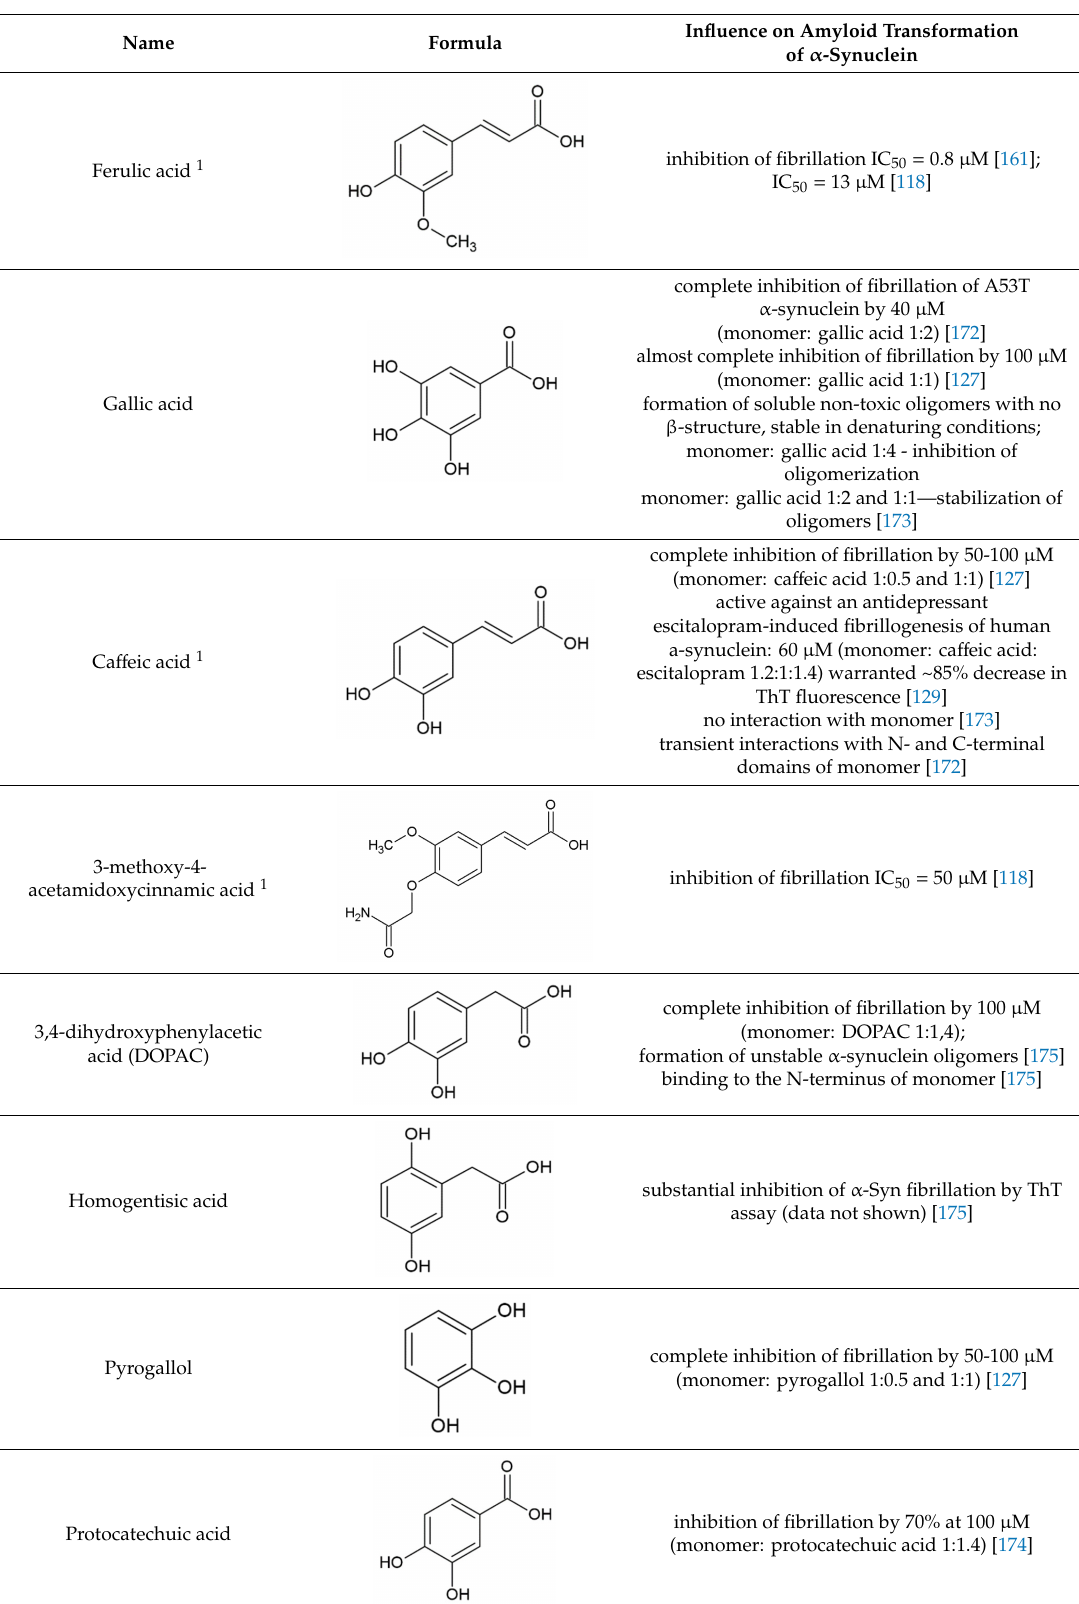
Table 1. Influence of hydroxycinnamic acid derivatives and structurally similar compounds